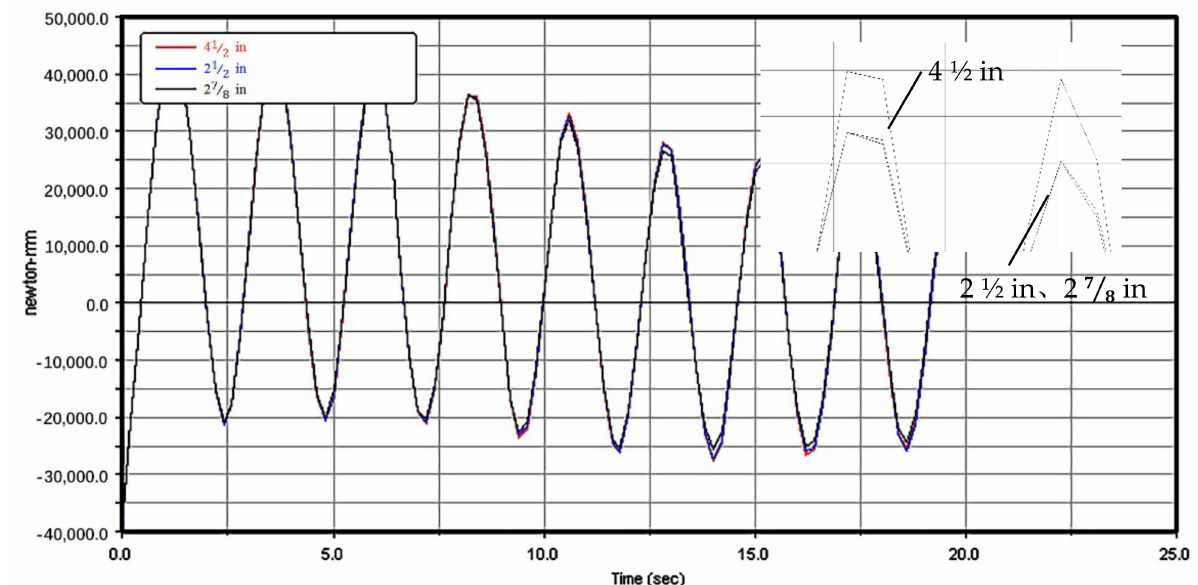
Figure 18. Displacement distribution in different-sized tubes.